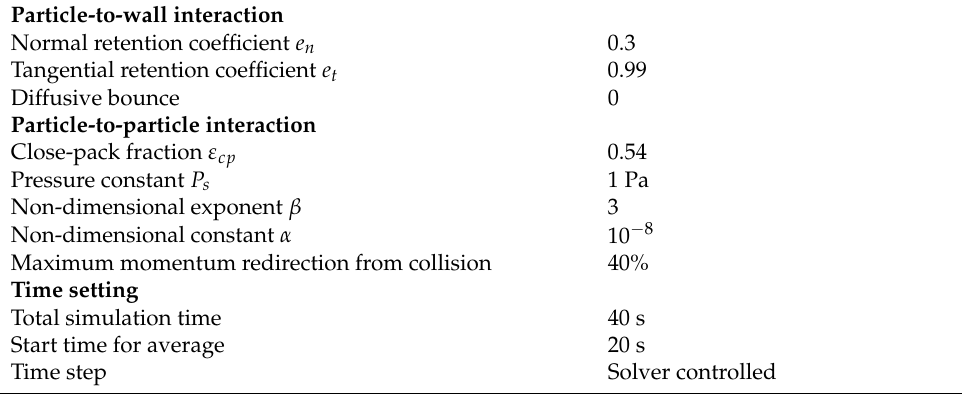
Table 6. Parameters for the simulation of the spouted